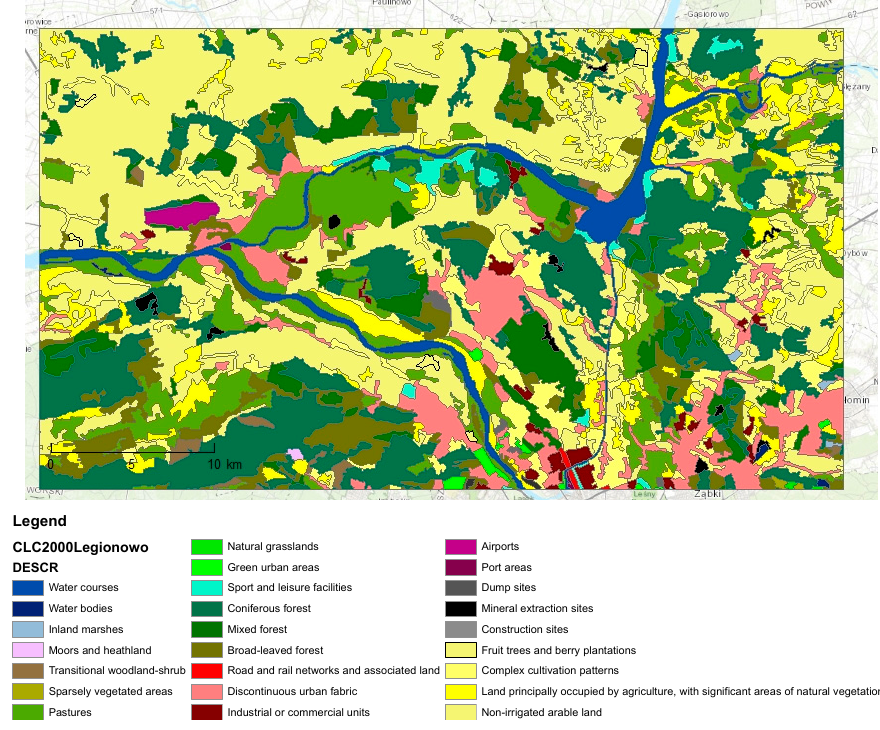
Figure 6. CORINE Land Cover map of testing scene [82].